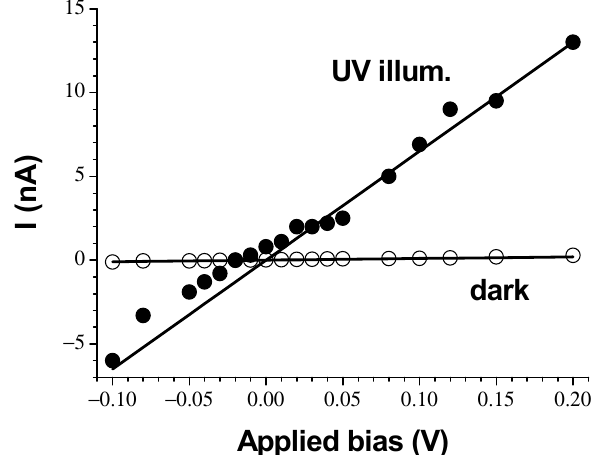
Figure 6. SEM image of NRs between In contacts. NR connecting In contacts is outlined with an oval.